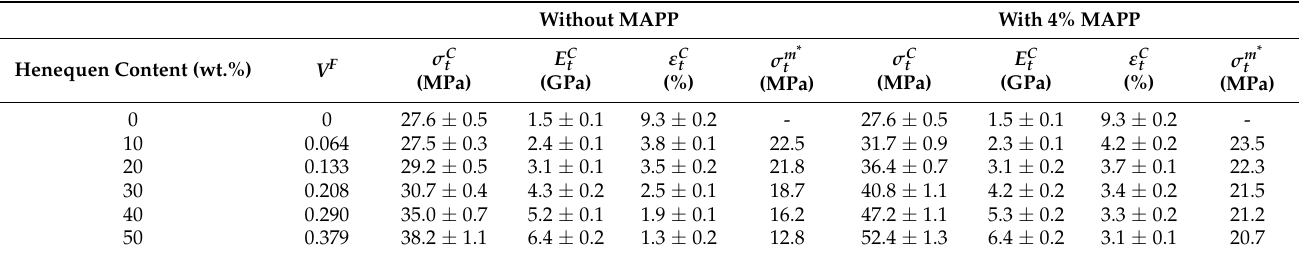
Table 1. Tensile properties for PP/Henequen composites with and without MAPP. Without MAPP With 4% MAPP Henequen Content